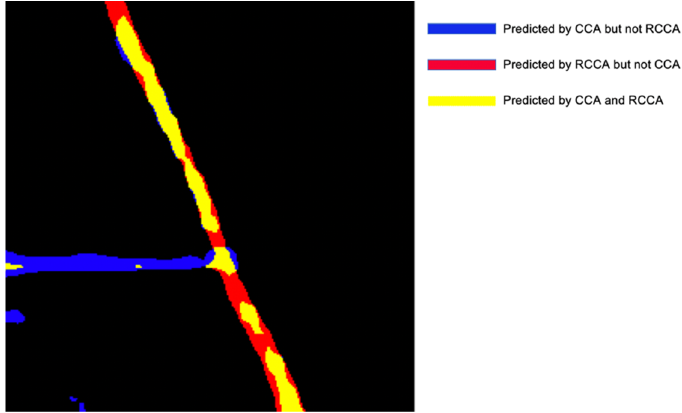
Figure 27 . The comparison between CCA module and RCCA module .